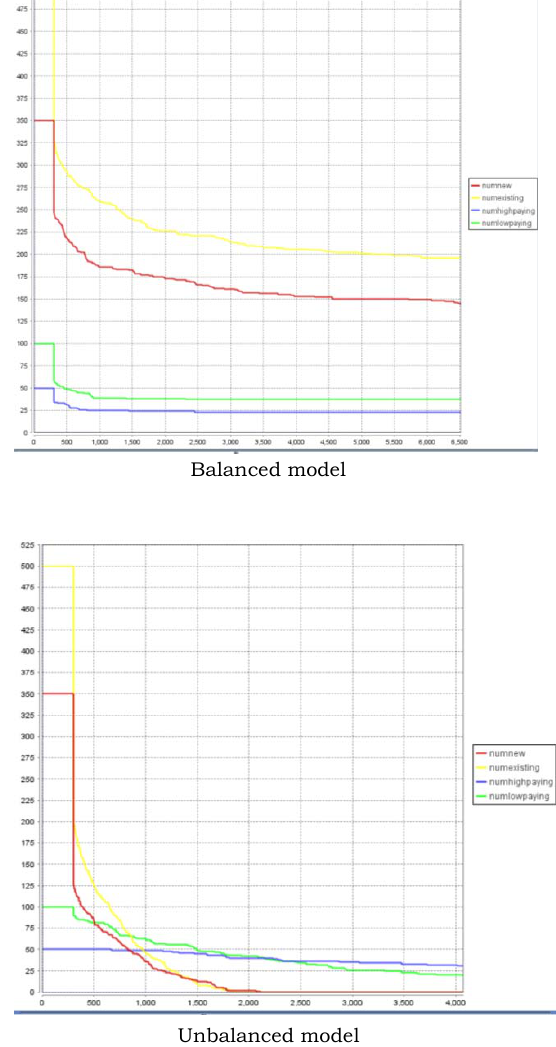
Figure 2. Comparison of the number of users in two